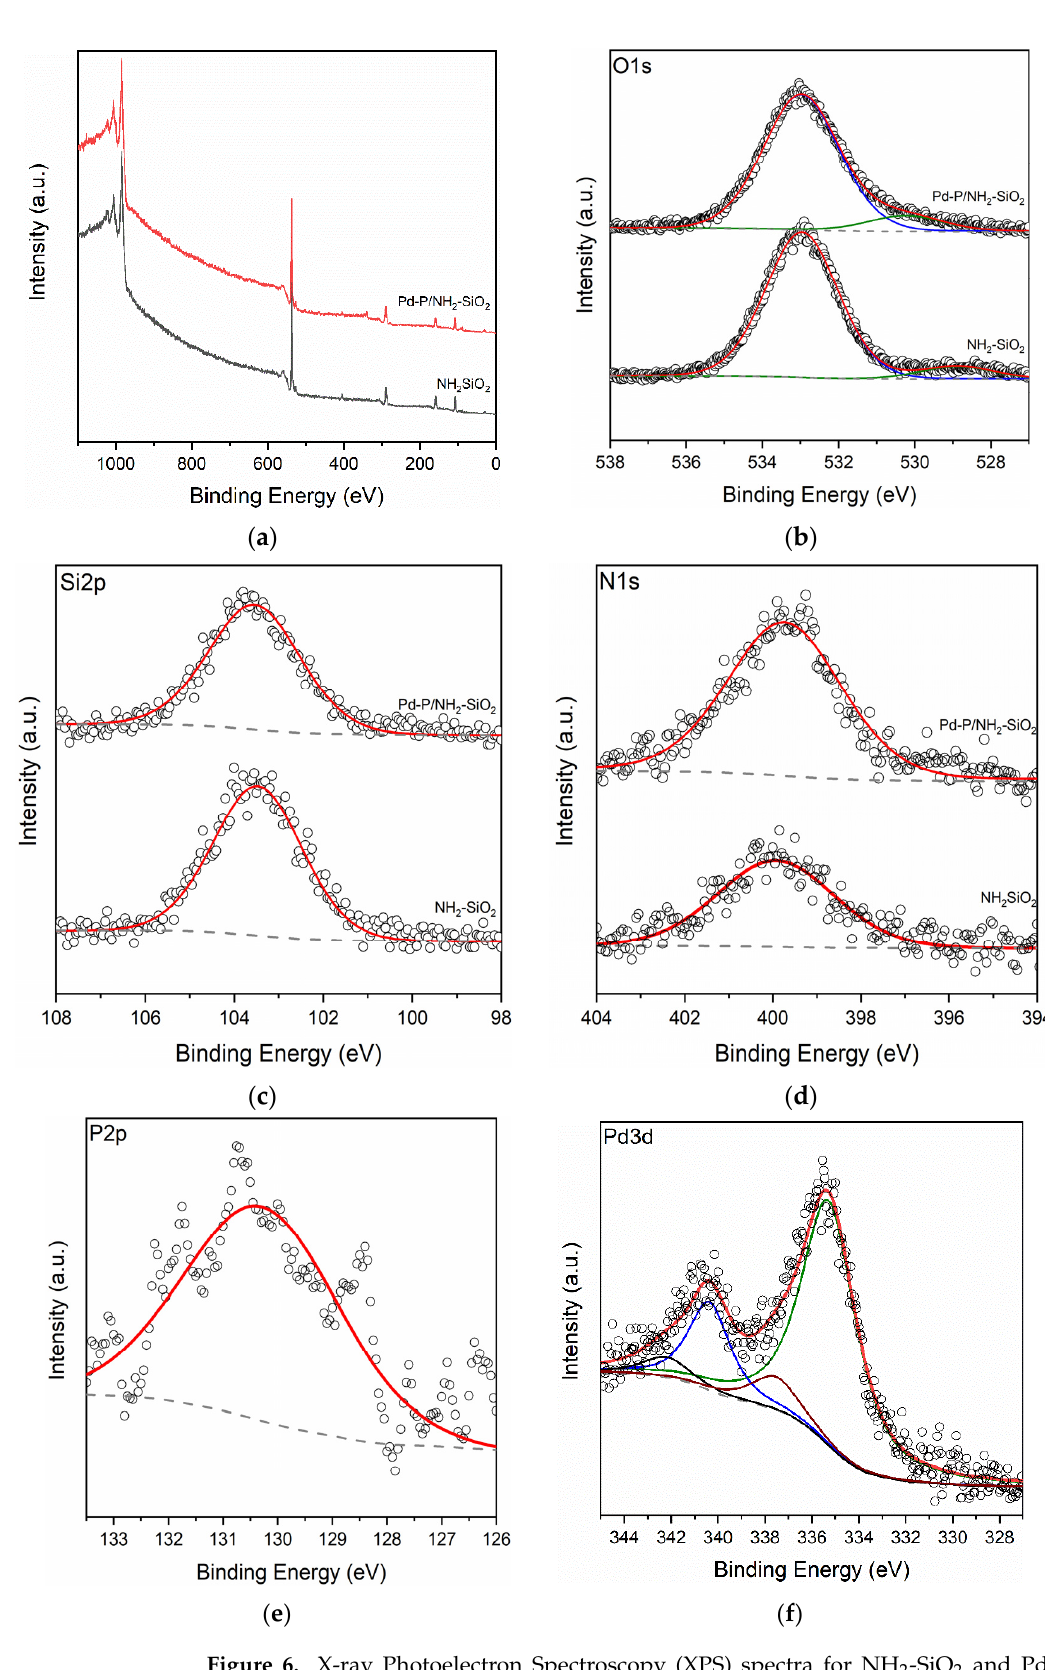
Figure 6. X-ray Photoelectron Spectroscopy (XPS) spectra for NH 2 -SiO 2 and Pd-P/NH 2 -SiO 2 : ( a ) complete range, and regions of ( b ) O 1s, ( c ) Si 2p, ( d ) N 1s, ( e ) P 2p, ( f ) Pd 3d core levels.